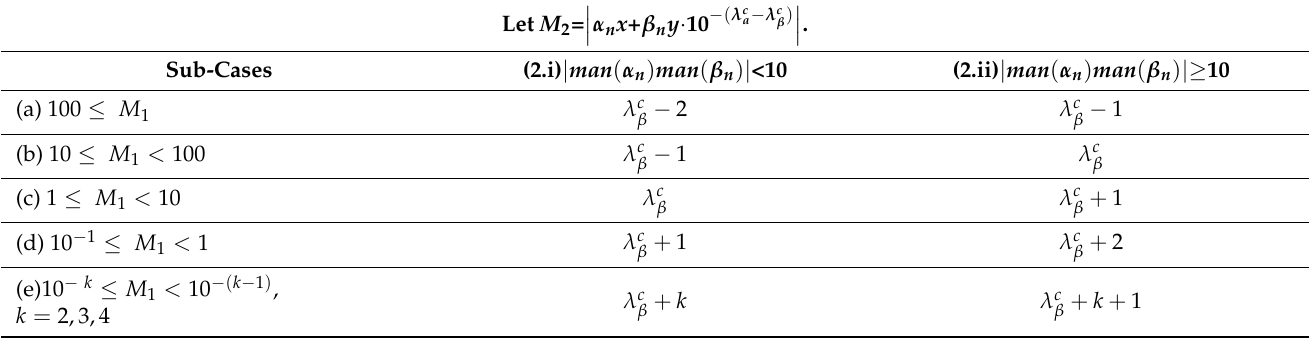
Table 2. It refers to Case 2, where λ c α (cid:54) = λ c the title “sub-cases”, the eventual values of M 2 = the possible values of the product | man ( α n ) man ( β n ) | are presented. The obtained number of correct decimal digits (c. d. d.) of product γ n = a n β n is shown in bold in each corresponding